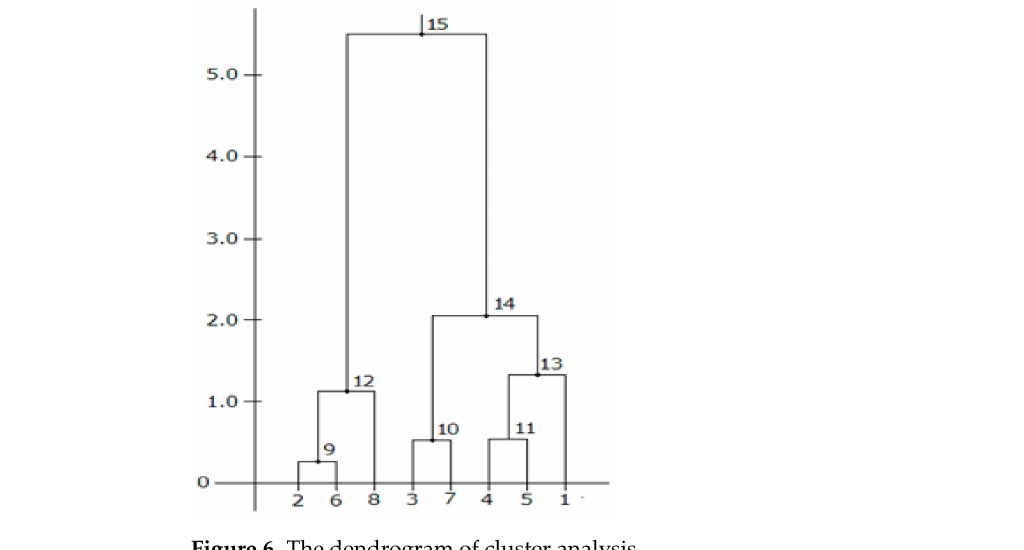
Figure 6. The dendrogram of cluster